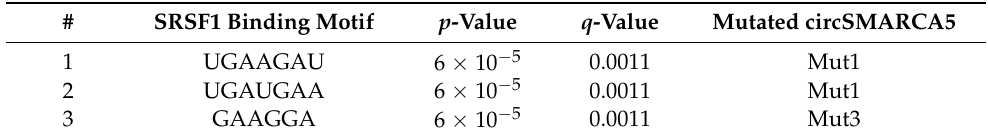
Table 2. Experimentally validated SRSF1 binding motifs significantly occurring within predicted SRSF1 BSs.